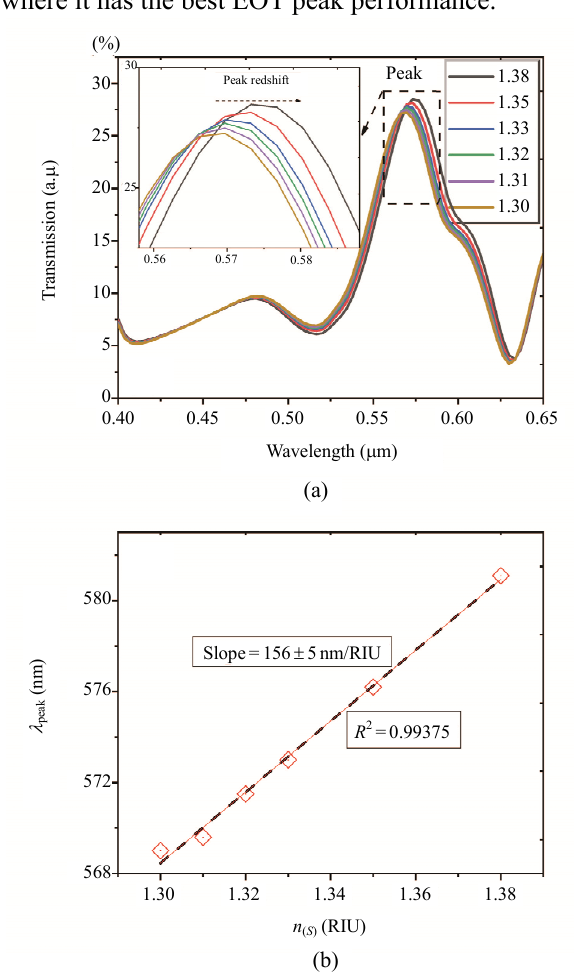
Fig. 5 Sensor performance analysis for (a) calculated zero-order transmission spectral for the sensor in various with function of the wavelength and (b) dependence of the corresponding n , showing the linear fitted result of  on s peak n  with different s peak